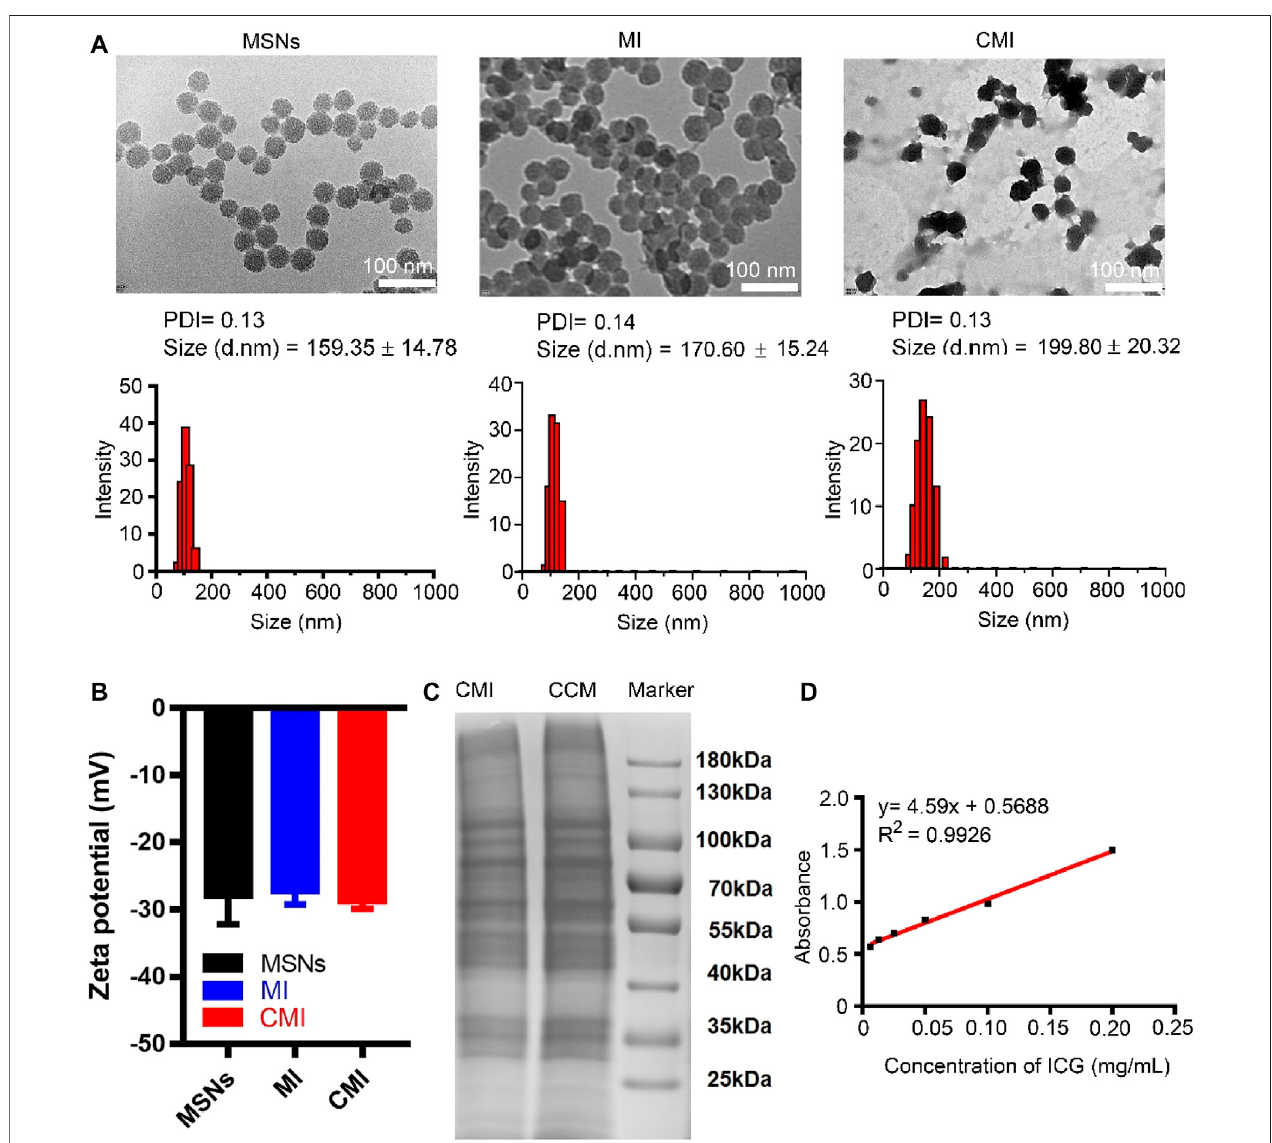
FIGURE2| CharacterizationofMSN-basednanoparticles. (A) TEMimagesandparticlesizesofMSNbasednanoparticles.Scalebaris100nmintheTEMimages. Particle sizes were also measured by DLS. (B) Zeta potential of the MSN-based nanoparticles. (C) SDS-PAGE analysis of MSN-based nanoparticles with 10% native polyacrylamide separating gel. (D) Standard curve of ICG via the UV-vis method.